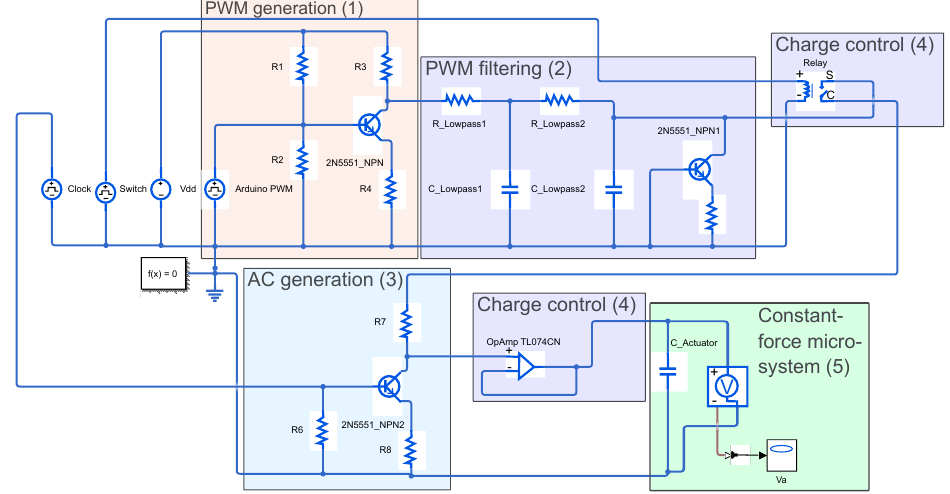
Figure 6. Excitation circuit for the reliable deflection of an electrostatic constant-force microsystem with PWM generation ( 1 ), PWM filtering ( 2 ), AC generation ( 3 ), the charge control components ( 4 ), and the constant-force microsystem ( 5 ) displayed by its